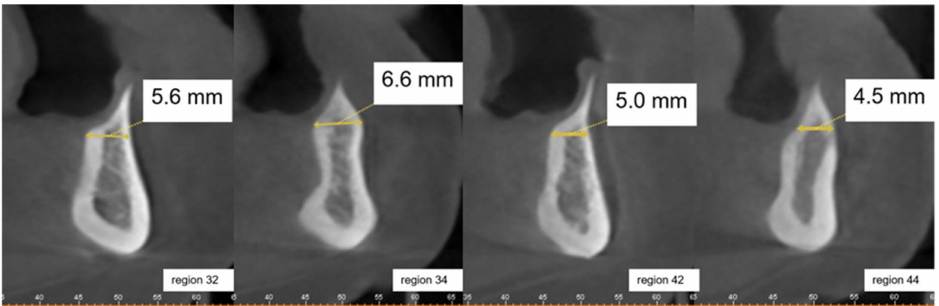
Figure 4. Sagittal planes from CBCT of regions 32, 34, 42, and 44 of Case Vignette 2. The alveolar ridge is substantially atrophied in the crestal region. The widths of the alveolar ridge (mm = millimeters) are provided in the respective cut-outs. The alveolar ridge height is